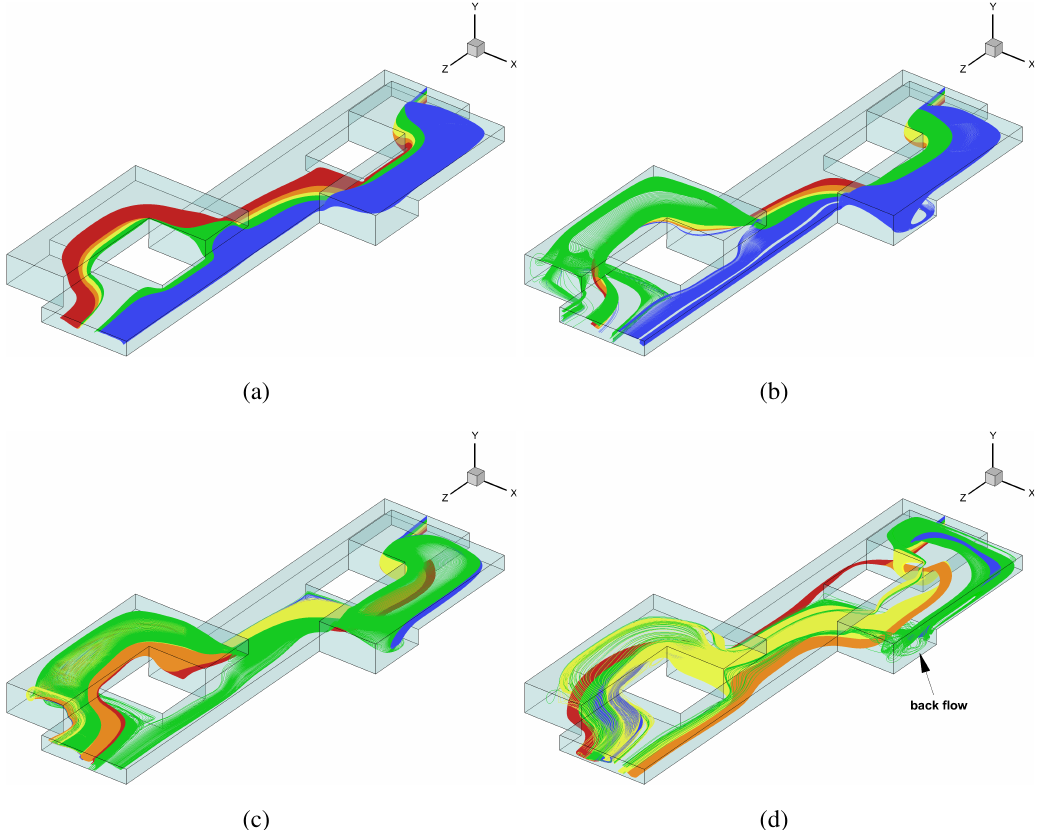
Figure 5. Deformation of the interface between two fluids in the mixer with α = 0 . 25 at the four Reynolds numbers, ( a ) Re = 10 , ( b ) Re = 30 , ( c ) Re = 50 and ( d ) Re = 70 . The interfacial line is composed of 5000 tracer particles with assigned colors dependent on their vertical